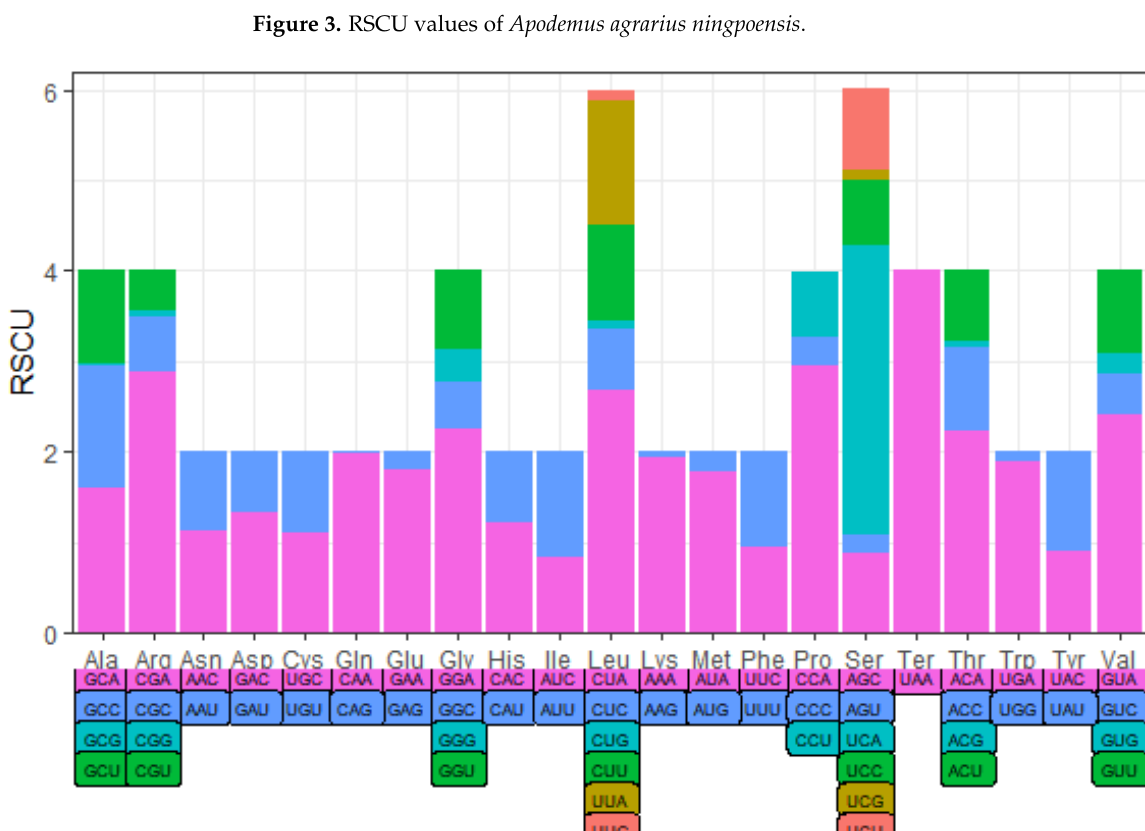
Figure 3. RSCU values of Apodemus agrarius ningpoensis .